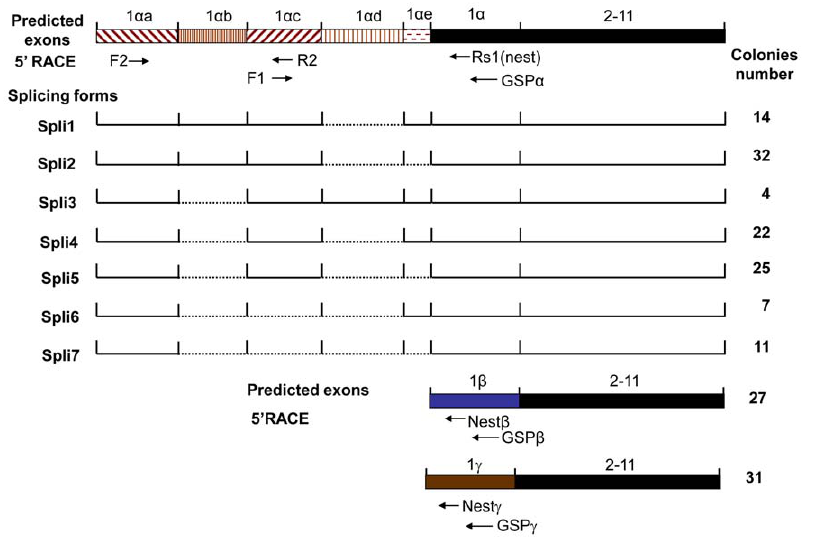
Figure 1. Characterization of N terminus of FBXW7 isoforms using 5 9 -RACE and bioinformatics analysis. Structural illustration of multiple splicing forms of FBXW7 a . Seven different splicing forms of FBXW7 a were identified by 5 9 -RACE using gene specific primer (GSP) and nest primer (Rs1). The number of colonies for each splicing form found during screening was shown. The N-terminal sequence of isoform b and c was also investigated by 5 9 -RACE using the corresponding primers GSP b , GSP c , Nest b and Nest c . The arrows represent the primers used in this study and their position in the corresponding sequence.